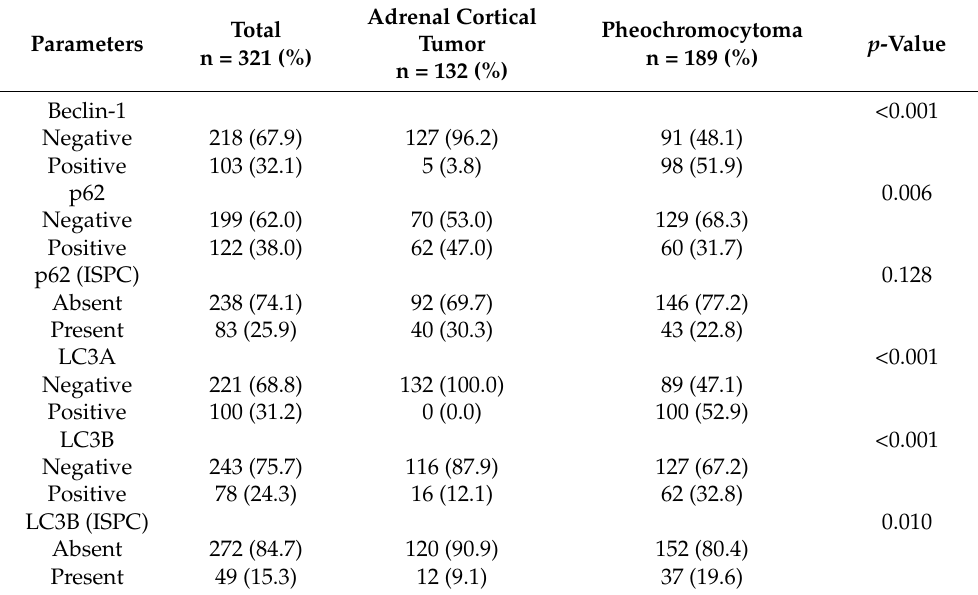
Table 1. Expression of autophagy-related proteins in adrenal cortical tumor and pheochromocytoma.